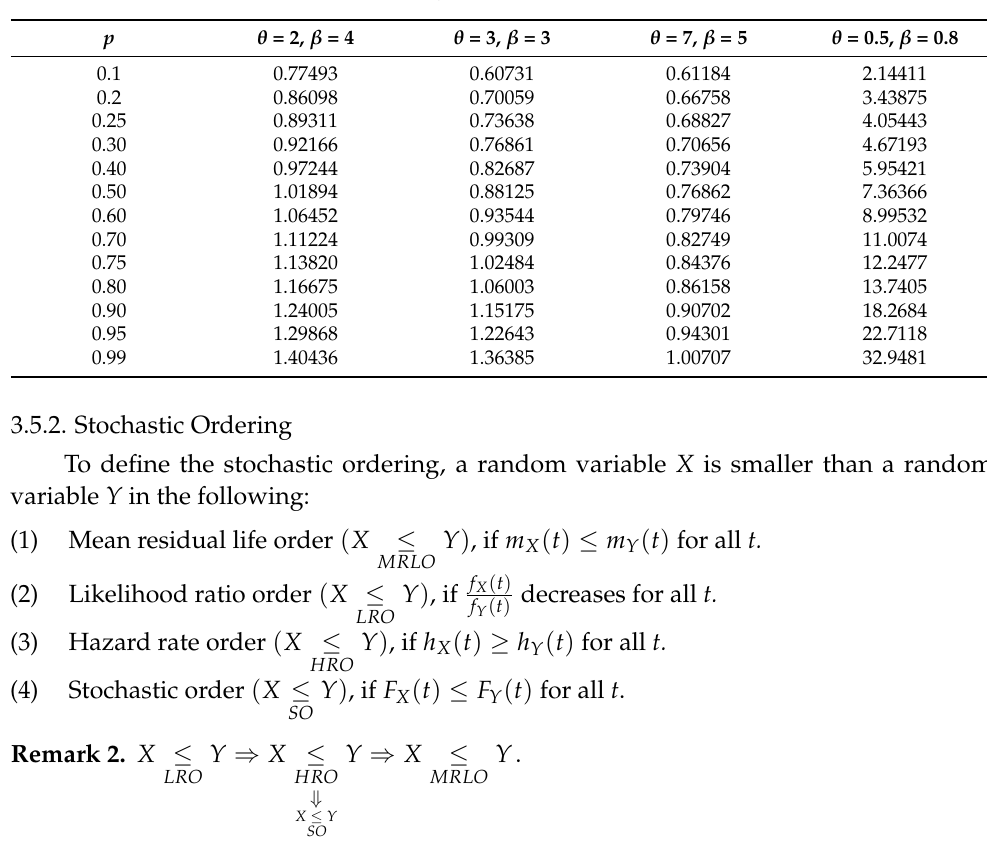
Table 2. Values for some selected values of p